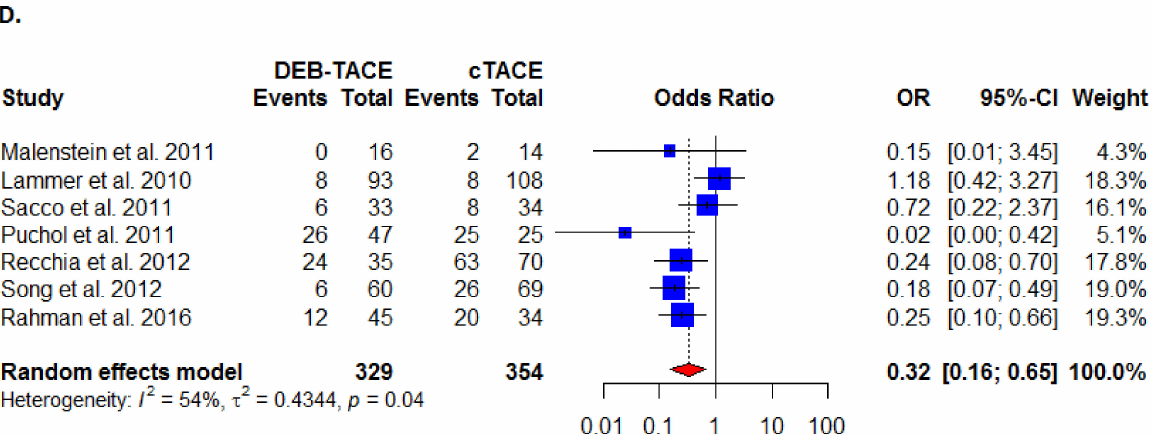
Figure 4. Forest plots for safety outcomes between DEB-TACE (experimental) and C-TACE (control) treatment in patients with hepatocellular carcinoma ( A ) systemic effects; ( B ) serious adverse events; ( C ) 30-day mortality; ( D ) end